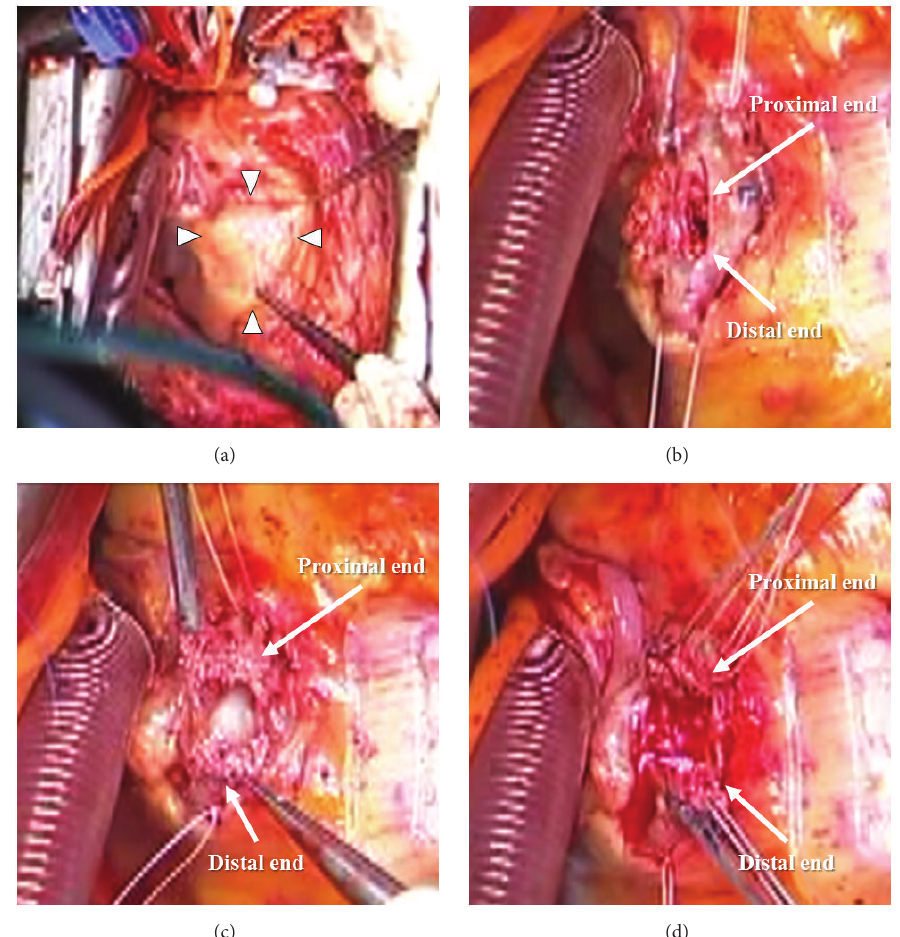
Figure 5: Intraoperative findings. The pseudoaneurysm is in the visceral adipose tissue (arrow heads) (a) and opened (b). (c) Coronary arterial transection. (d) Proximal and distal transected ends are